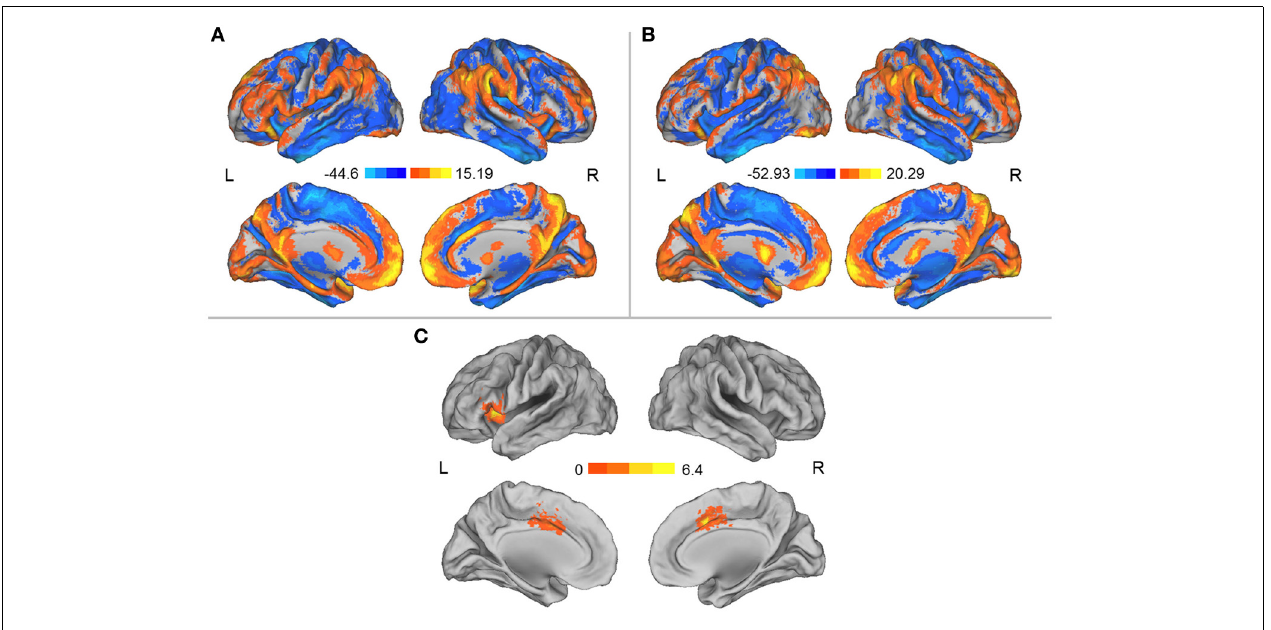
FIGURE 1 | (A) Spatial distribution of the DCs before HDT bed rest. (B) Spatial distribution of the DCs after HDT bed rest. (C) Regions exhibiting significant changes in DC between the pre- and post-HDT bed rest